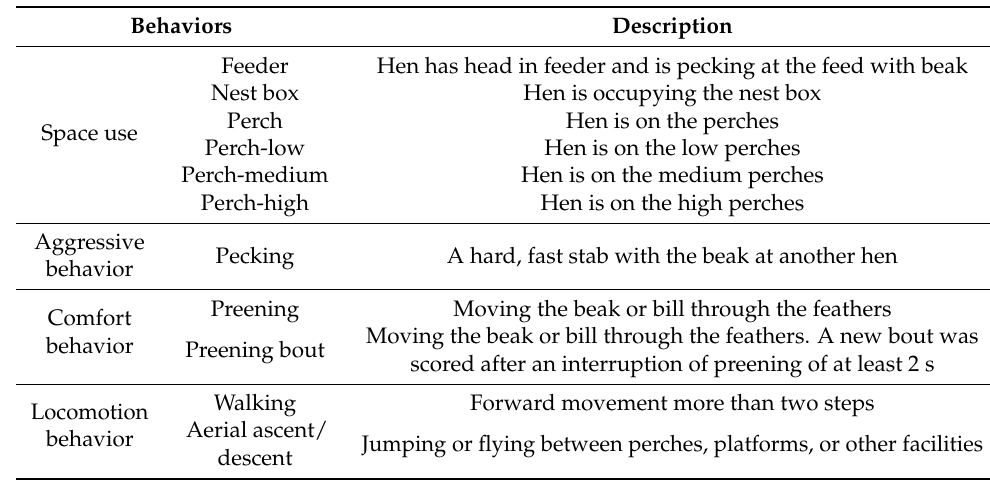
Table 1. Ethogram of observed behaviors in the perchery